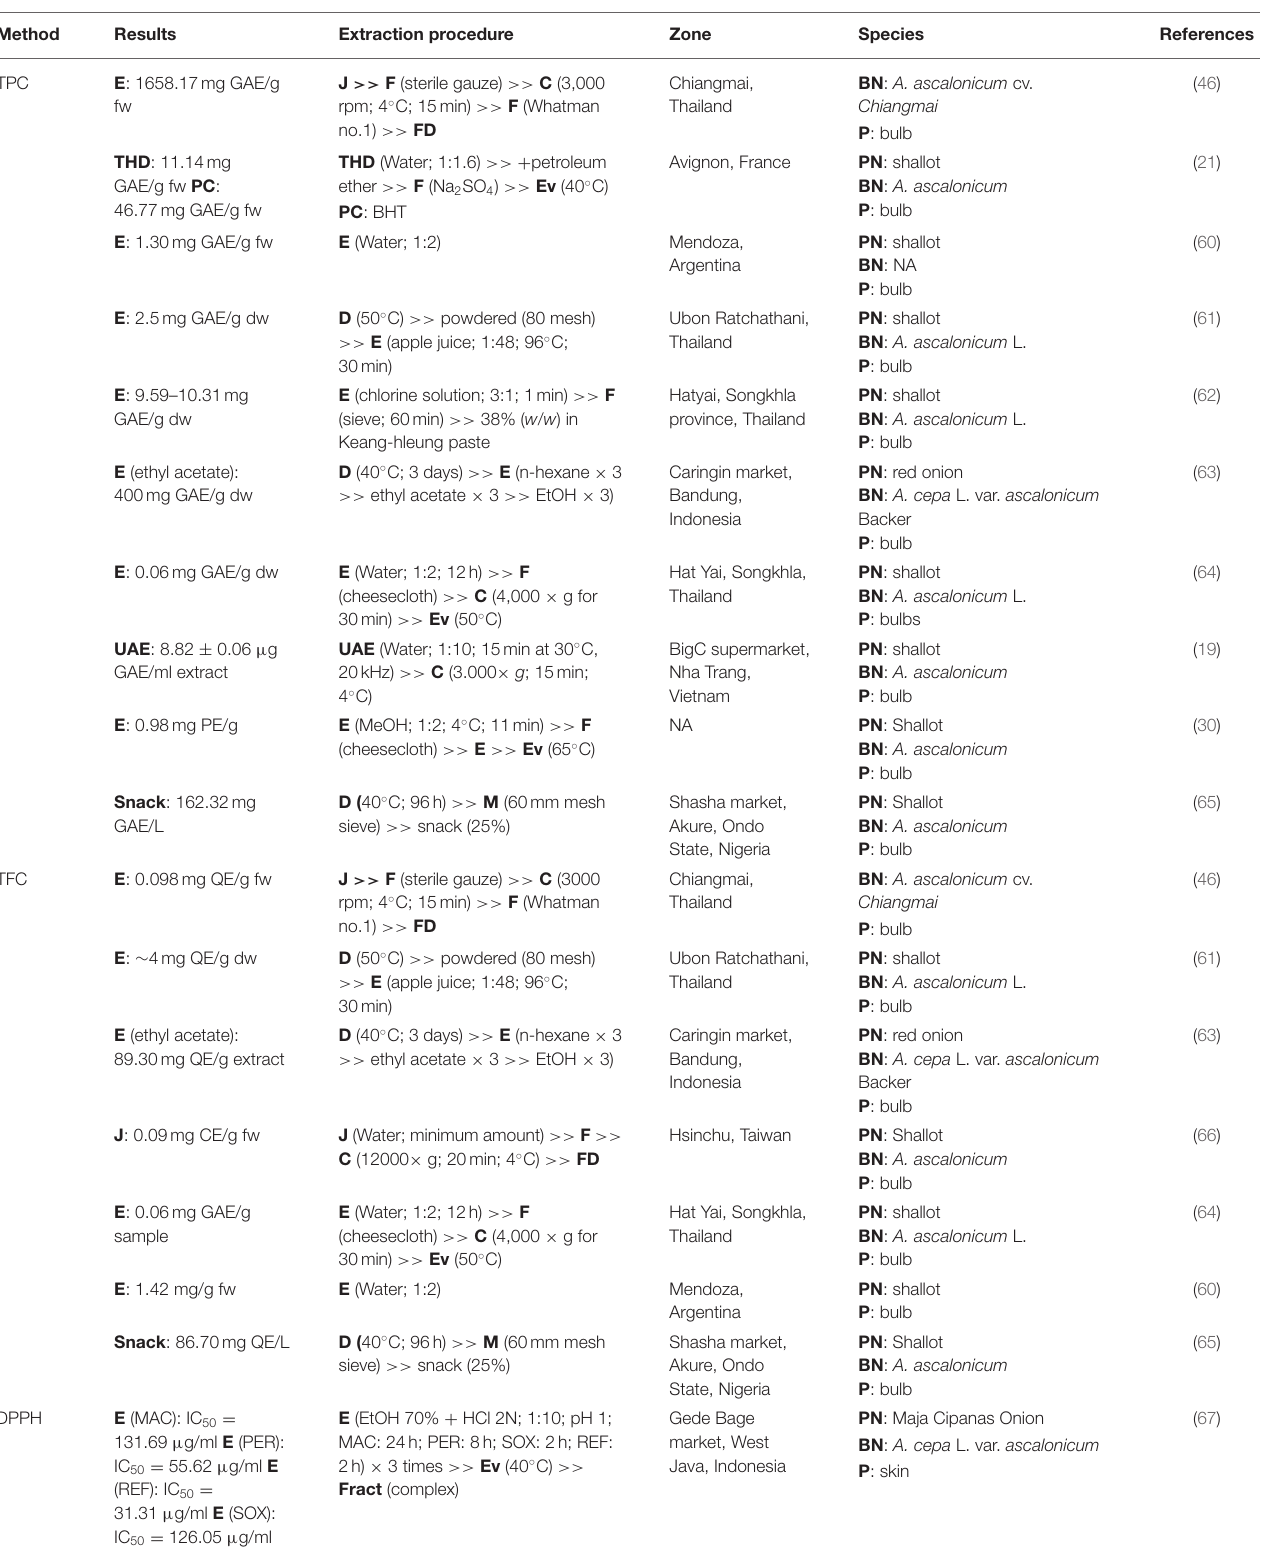
TABLE 2 | Summary of main antioxidant activity exerted by shallot extracts.